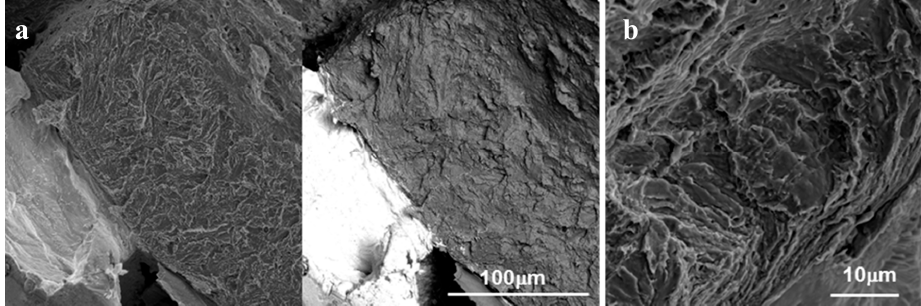
Figure 9. Details of Solid Metal Induced Embrittlement (SMIE) crack surrounding the fracture surface of the notched specimen (B07), originally covered by the flux and Pb layer, tested in a cell under Ar gas at 300 °C, R2 (2 × 10 − 8 m/s). ( a ) SE and BSE images of large SMIE cleavage-like crack initiating from the notch surface pre-covered by Pb; ( b ) Detail of short SMIE cleavage-like crack surrounded by ductile deformation.